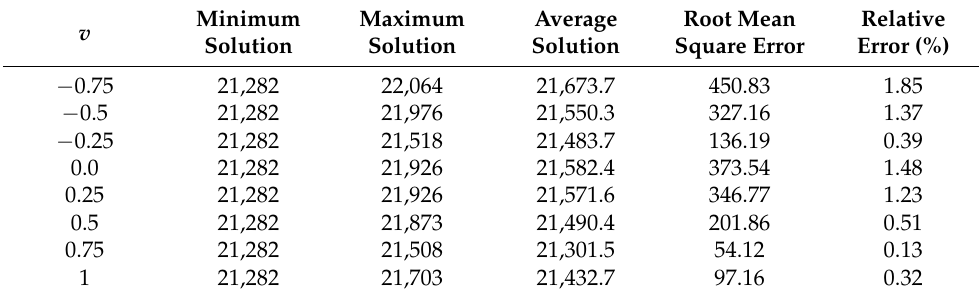
Table 3. Evaluation of FMCA in KroA100 with the change of fractional-order v